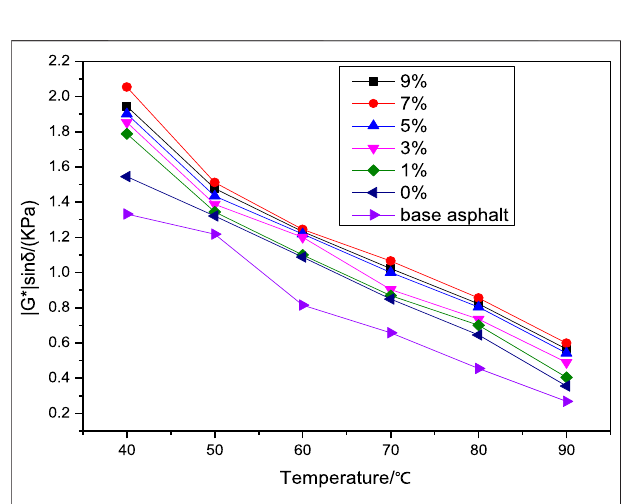
FIGURE 10 | Effect of PP-g-MAH content on δ of modi fi ed asphalt.